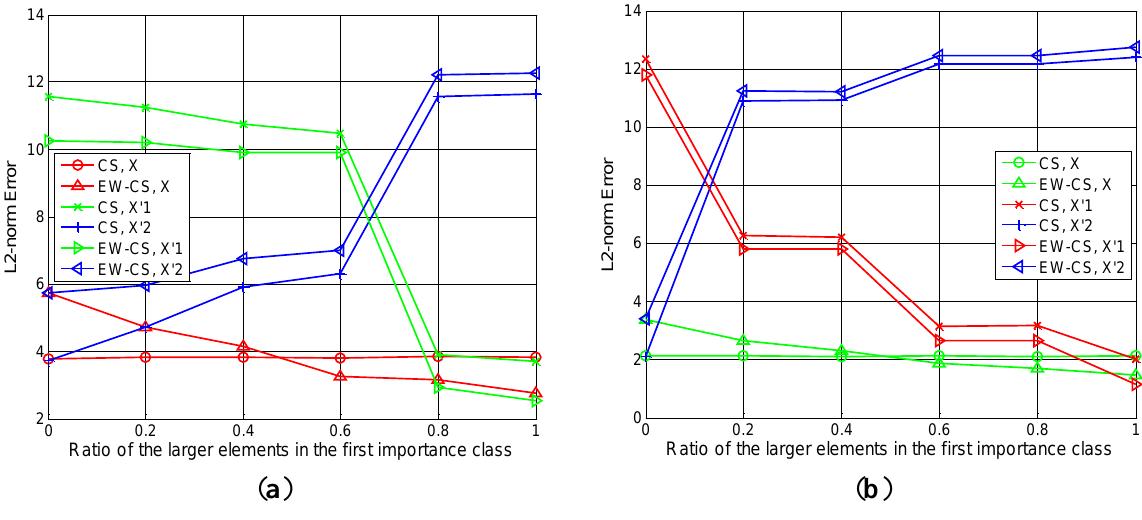
Figure 6. The l -norm recovery error with different Λ 2